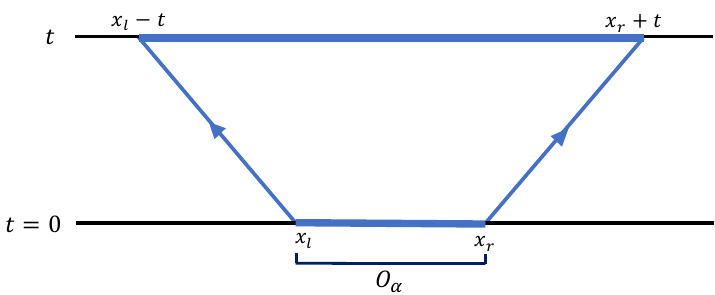
Figure 3 . Under time-evolution, the end points of an operator O α move at the light-cone speed v c = 1 in opposite directions. The initial operator with endpoints at x l and x r can become a superposition of many final operators at time t , each of which have endpoints x l − t and x r + t